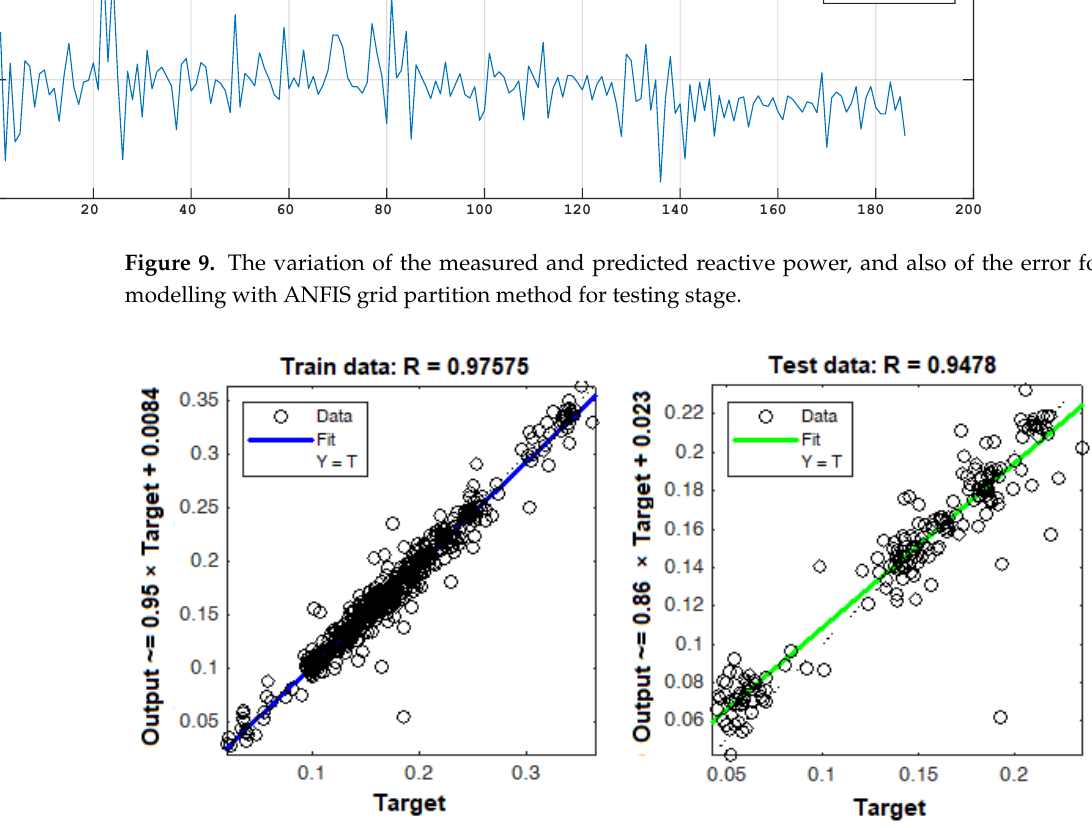
Figure 10. Regression coefficients for the training and testing phase for modelling with ANFIS grid partition method.